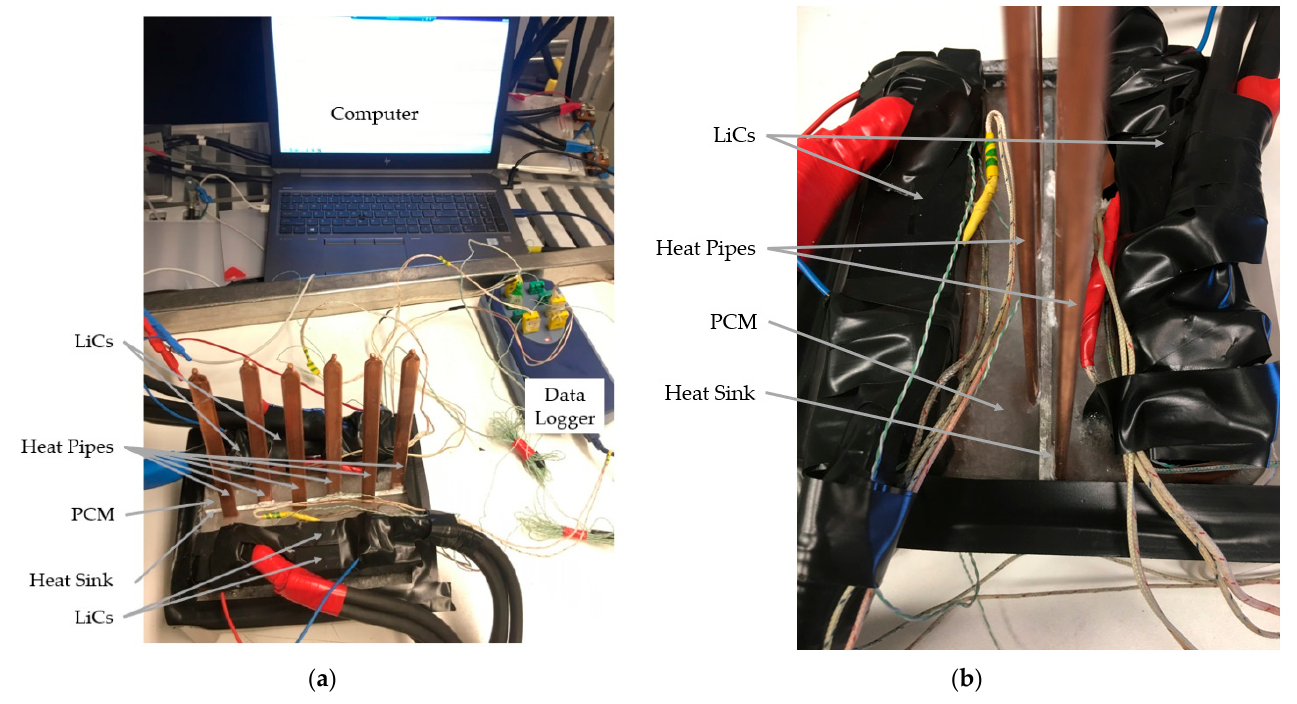
Figure 1. ( a ) Schematic of the experimental test bench, including a hybrid HPA-TMS, computer, and the data logger; ( b ) top view of the test bench.